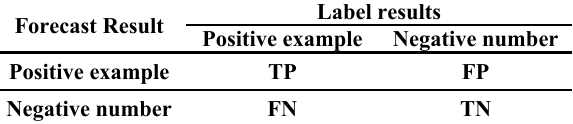
Table 2. Confusion matrix